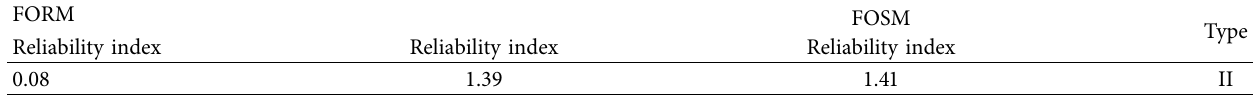
Table 4: Results of reliability analysis of cold-rolled two-story steel frame by RT program. FORM